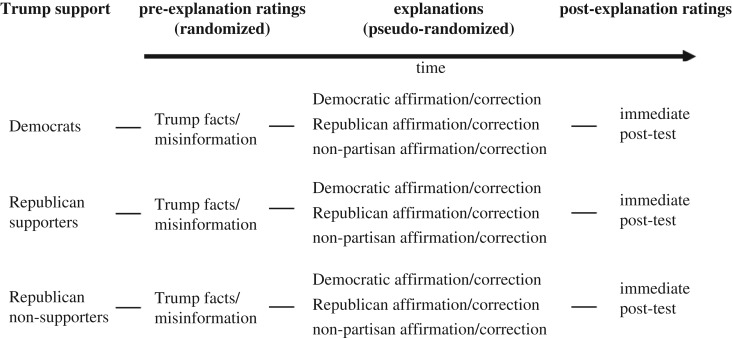
Design schematic of Experiment 2.